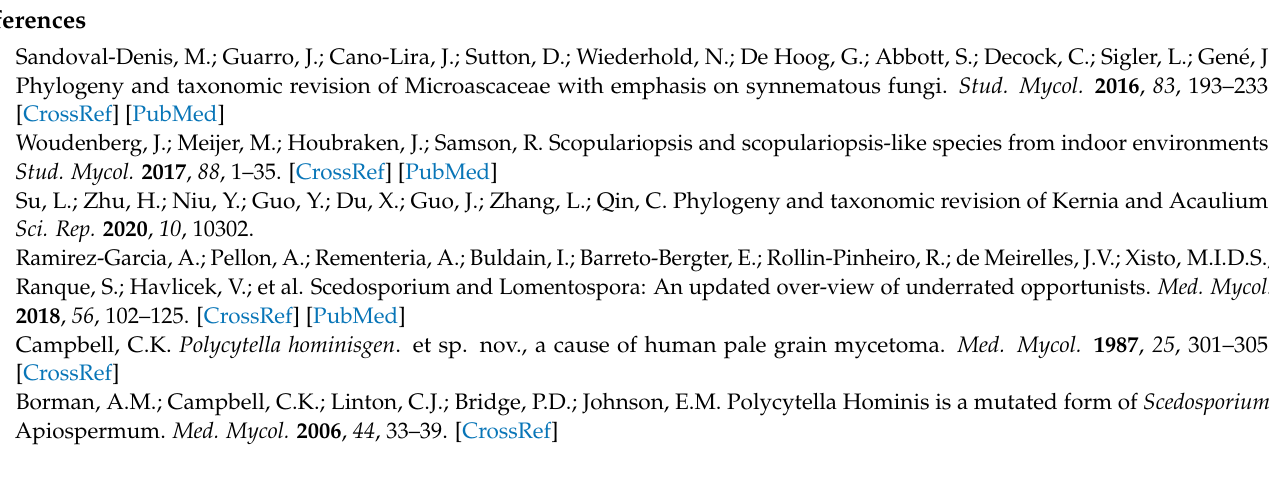
Supplementary Materials: Table S1. Preliminary molecular identification of Scedosporium Argen- tinian strains based on TUB2 sequences. Table S2. Preliminary molecular identification of Scedospo- rium Argentinian strains based on ITS sequences. Table S3. Growing rates of S. americanum on OA and PDA at 25 ◦